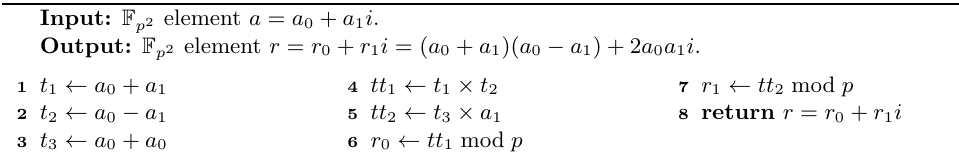
Algorithm 6: F -squaring with 1-way parallelization at F p -level. p 2